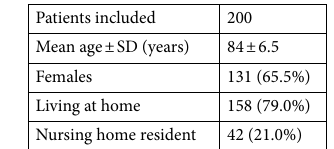
Table 1. Socio-demographic outline of the study population.